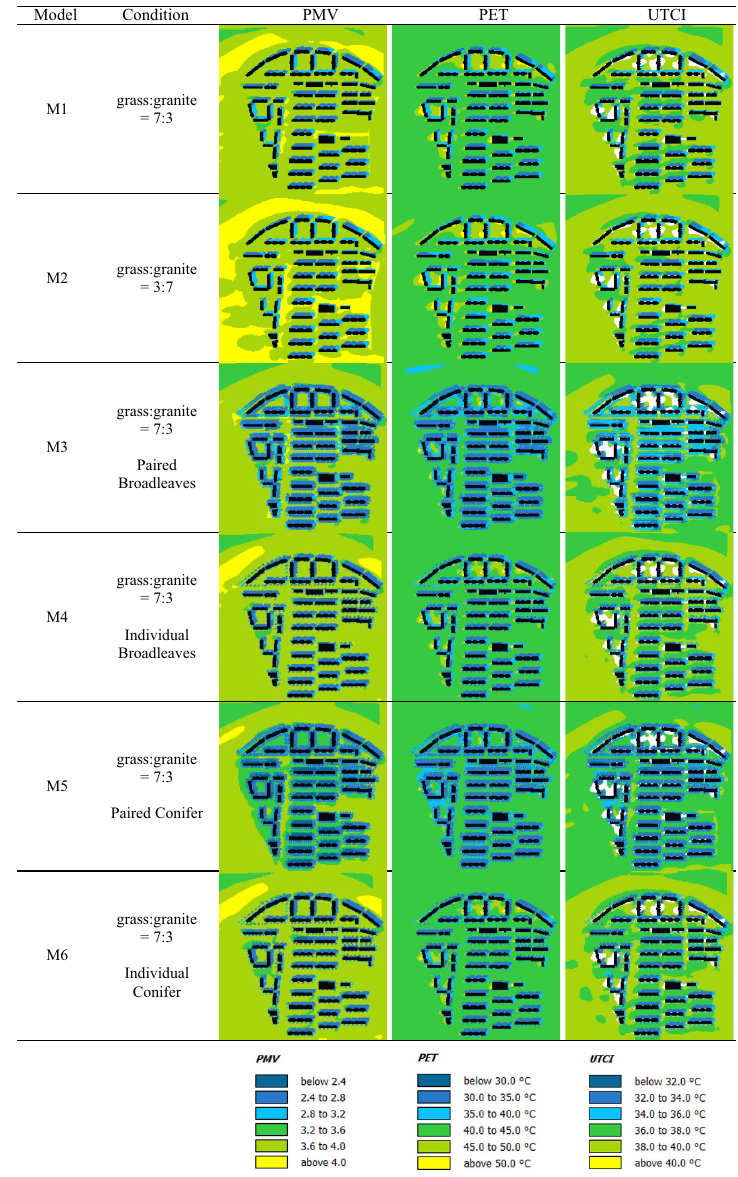
Figure 5. Simulation results of PMV, PET and UTCI under normal heat